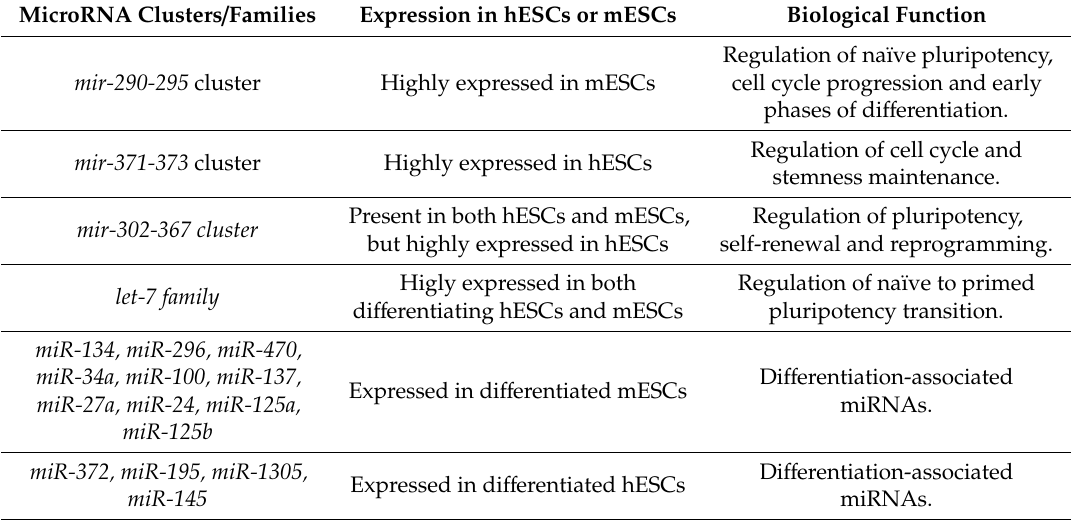
Table 2. MicroRNAs expression and roles in hESCs (human embryonic stem cells) vs. mESCs (mouse